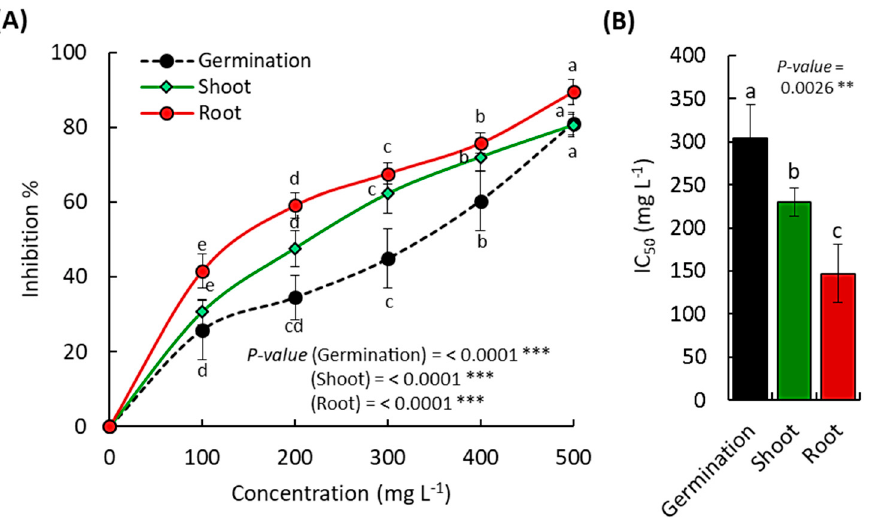
Figure 2. Phytotoxic activity of the EO extracted from the resin of Araucaria heterophylla against the germination and seedling growth of the weed Chenopodium murale . ( A ) the inhibitory effect with concentration, and ( B ) the IC 50 value (the concentration of the EO required for 50% inhibition). The bars represent the standard deviation ( n = 3 ). ** p < 0.01, *** p < 0.001.